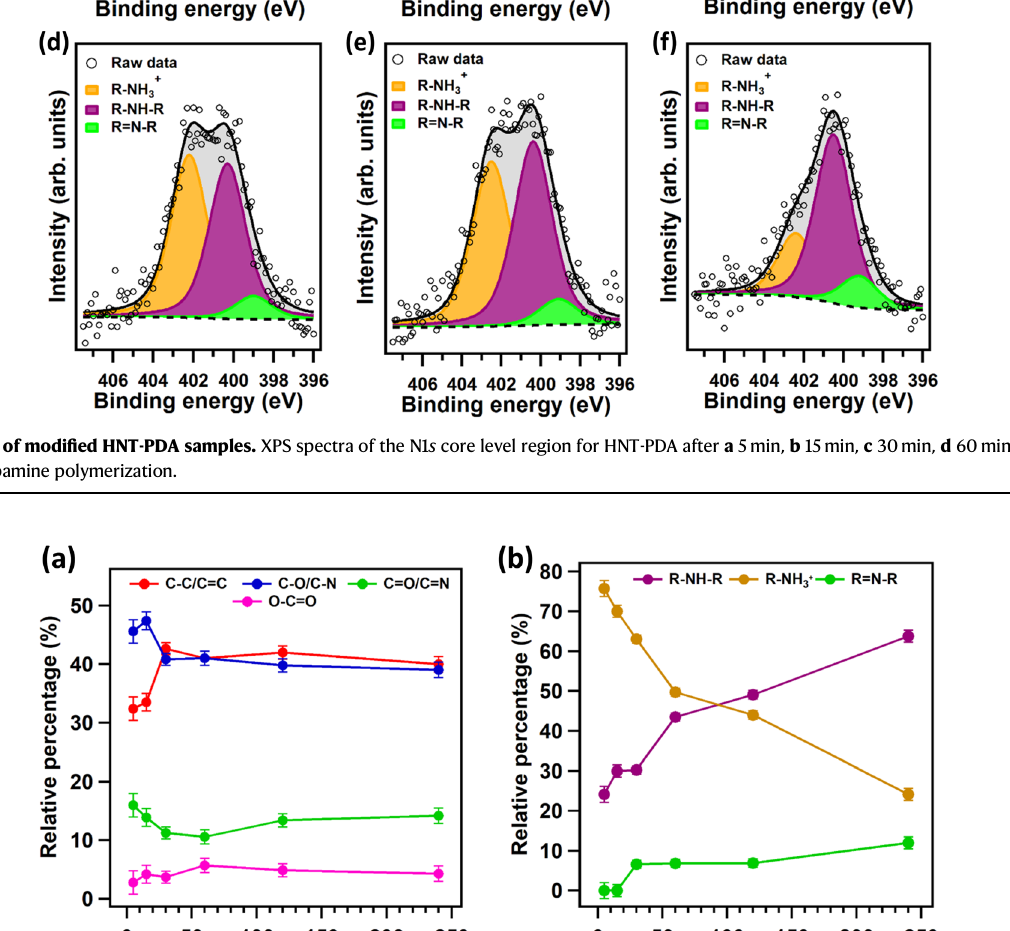
Fig.8fshowsthatTRISismoreprominentlypresentatthebeginningof